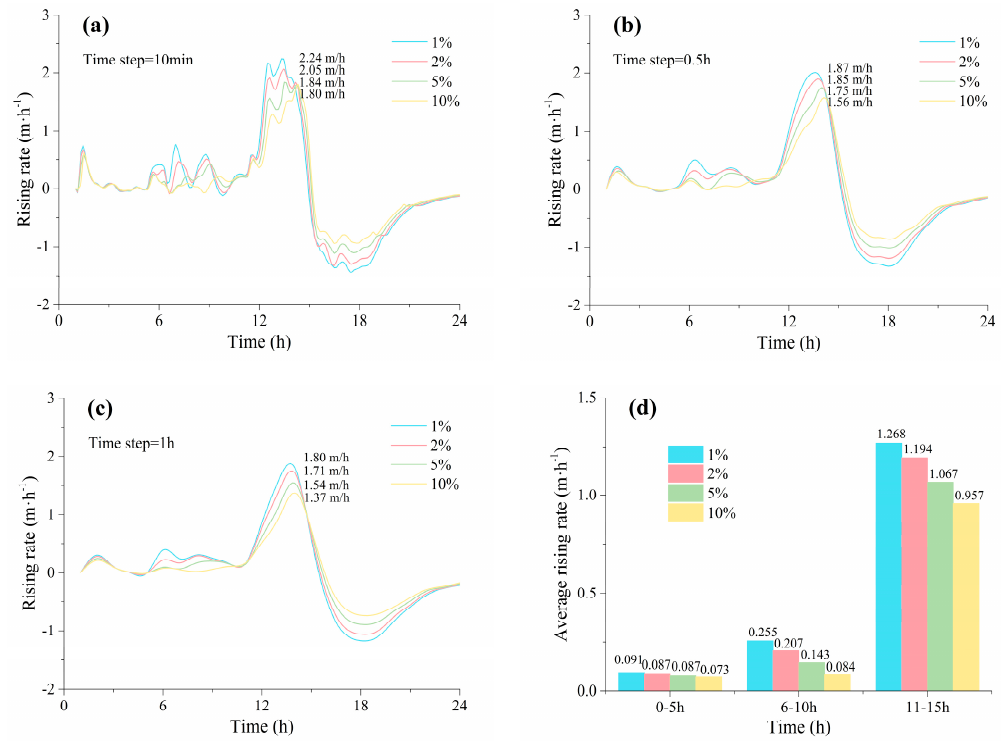
Figure 8. The variation in the rising rate of the flood stage with three computation time steps (10 min ( a ), 30 min ( b ), and 1 h ( c )), and the average rising rates in the rising limb of the flood hydrographs ( d ).